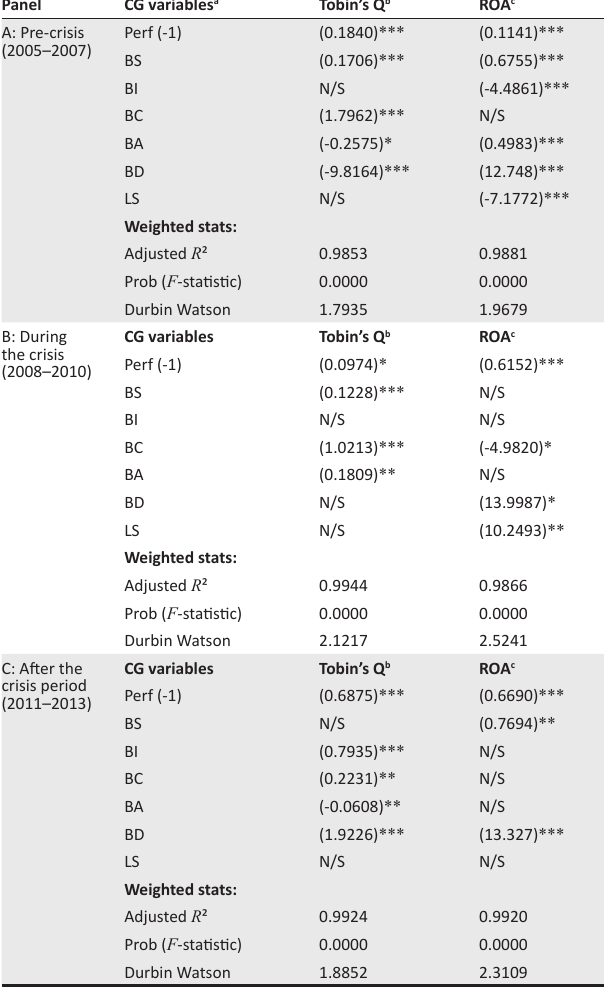
Note: Table 4 shows regression results of the impact of corporate governance attributes on Tobin’s Q and ROA for the consumer goods industry. Column 1 shows the